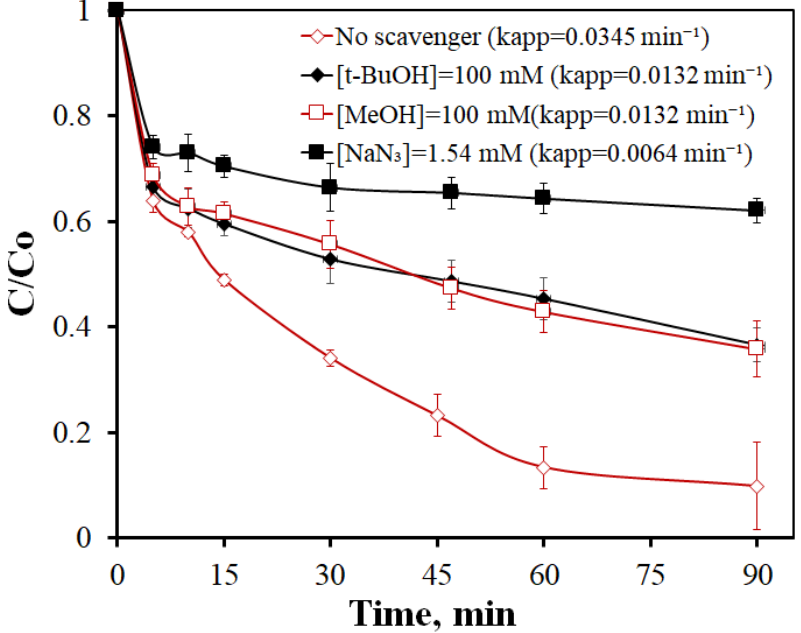
Figure 8. LOS degradation without and with radical scavengers. Experimental conditions: (LOS) = 250 μ g/L, (SPS) = 250 mg/L, (acid–BC) = 90 mg/L in UPW.